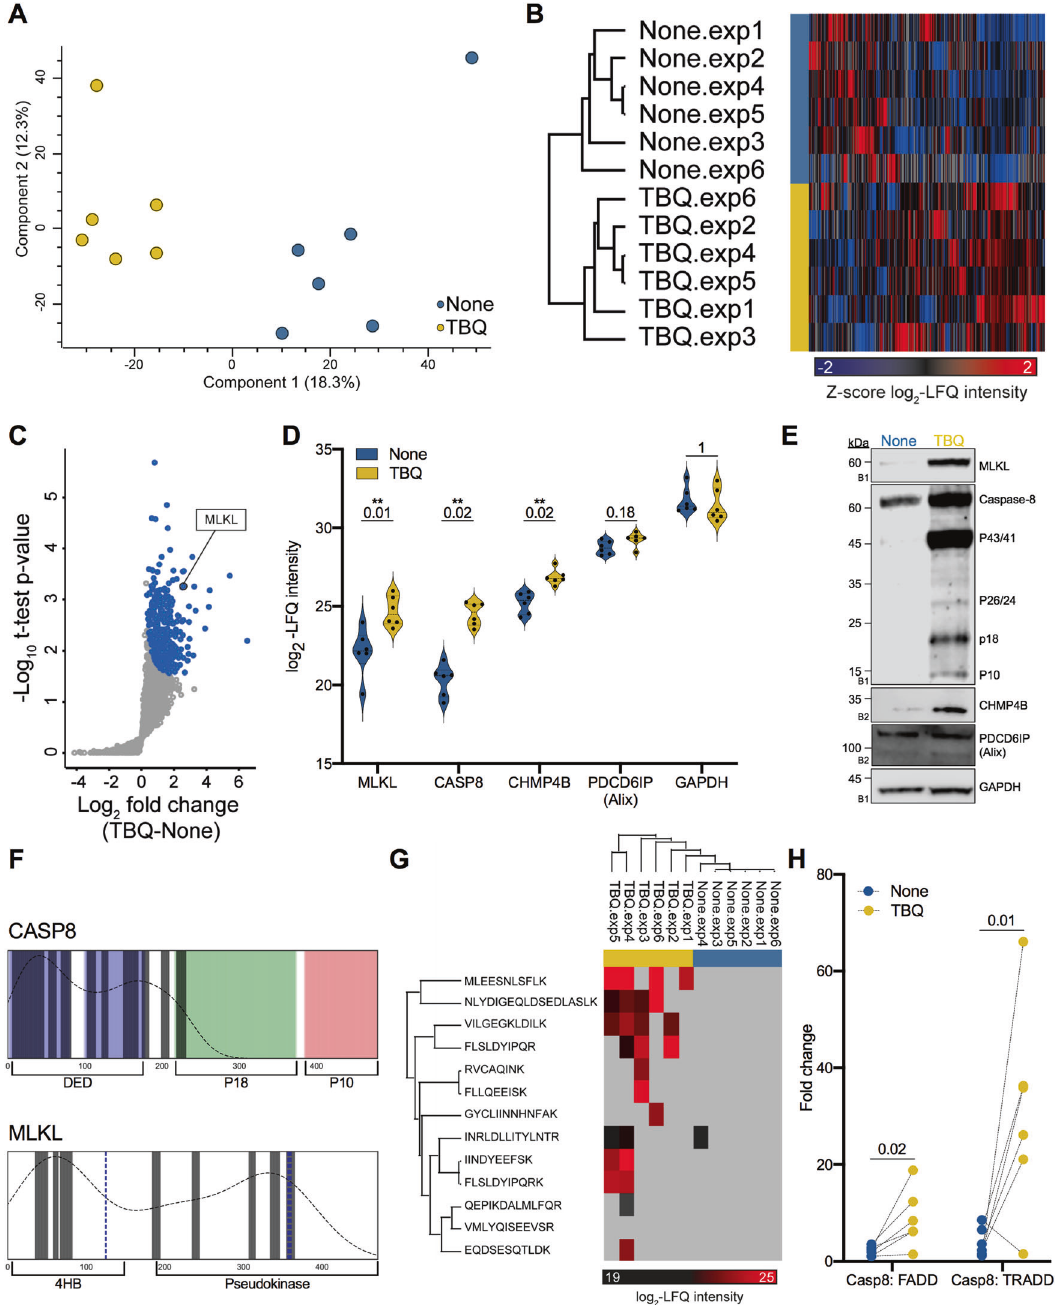
Fig. 2 Proteome distinguishes between control and necroptotic EVs. A Principal component analysis of biological replicates of extracted EVs showing that samples separate based on treatment (none vs. TBQ). B Unsupervised hierarchical clustering analysis of 2984 identi fi ed proteins between biological replicates, named by EV extraction. Color represents the Z -score of log 2 -LFQ intensity of each protein. C Volcano plot representing a one-sided t -test analysis of necroptotic (TBQ) vs. control (none) EVs. 352 proteins were signi fi cantly upregulated in the necroptotic EVs and will be termed “ TBQ EV-enriched proteins ” (blue, FDR cutoff = 0.1, S0 = 0.1). MLKL is marked. D Violin plots showing log 2 - LFQ intensity of selected identi fi ed proteins. Q -value is mentioned individually above each plot, * Q < 0.1, ** Q < 0.05. E Validation of the selected EV proteins from ( D ) by immunoblot analysis of EVs from untreated and TBQ-treated cells using antibodies against MLKL, caspase-8, CHMP4B, PDCD6IP (Alix), and GAPDH. F Alignment of the full-length caspase-8 and MLKL protein structures with peptides detected by MS analysis (marked as bars). Key structures of caspase-8 are colored and labeled: DED domains in blue, p18 subunit in green, and p10 subunit in red. Key structures of MLKL are labeled and phosphorylation sites are marked in blue. The dotted curve represents the density of the detected peptides along the full protein structure. G Hierarchical clustering analysis of caspase-8 peptides detected by MS analysis. Color represents the log 2 -LFQ intensity of each peptide, gray represents undetected levels. The few peptides that are not aligned with the DED domains, i.e., EQDSESQTLDK and GYCLIINNHNFAK, are detected only in a single sample. H Dot plot showing the fold change in LFQ intensity between caspase-8 and FADD, or TRADD, paired by experiment. p -Value for the multiple t -test is shown. E EVs for validation were extracted independently of the six pairs of biological replicates that were analyzed by mass spectrometry. The number on the left of each blot indicates the blot number, each corresponding to an independent EV extraction. EVs, extracellular vesicles; TBQ, TNF- α , Birinapant, and QVD-OPh; LFQ, label-free quanti fi cation, CASP8, caspase-8; FDR, false discovery rate; 4HB, N-terminal four-helix bundle. Cell Death and Disease (2021)